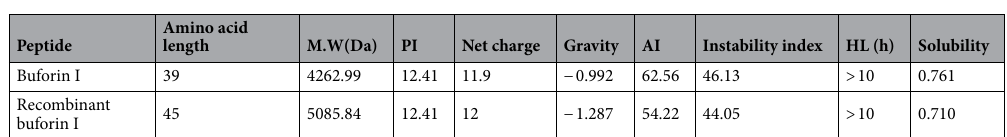
Table 2. Physical and chemical features of buforin I and recombinant buforin I by Protparam. MW, Molecular weight; AI, Aliphatic index; PI, isoelectric point; Net charge, Charge at pH = 7.4 (cytoplasm); HL, half-life considered in E. coli , in vivo; h, hours.